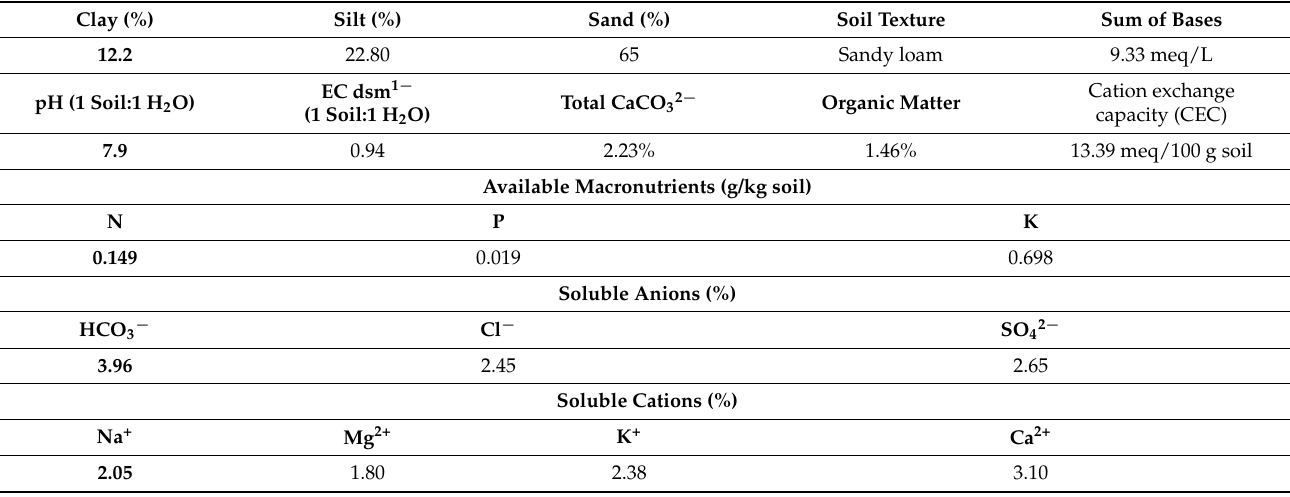
Table 1. Physicochemical characteristics of the experimental soil.